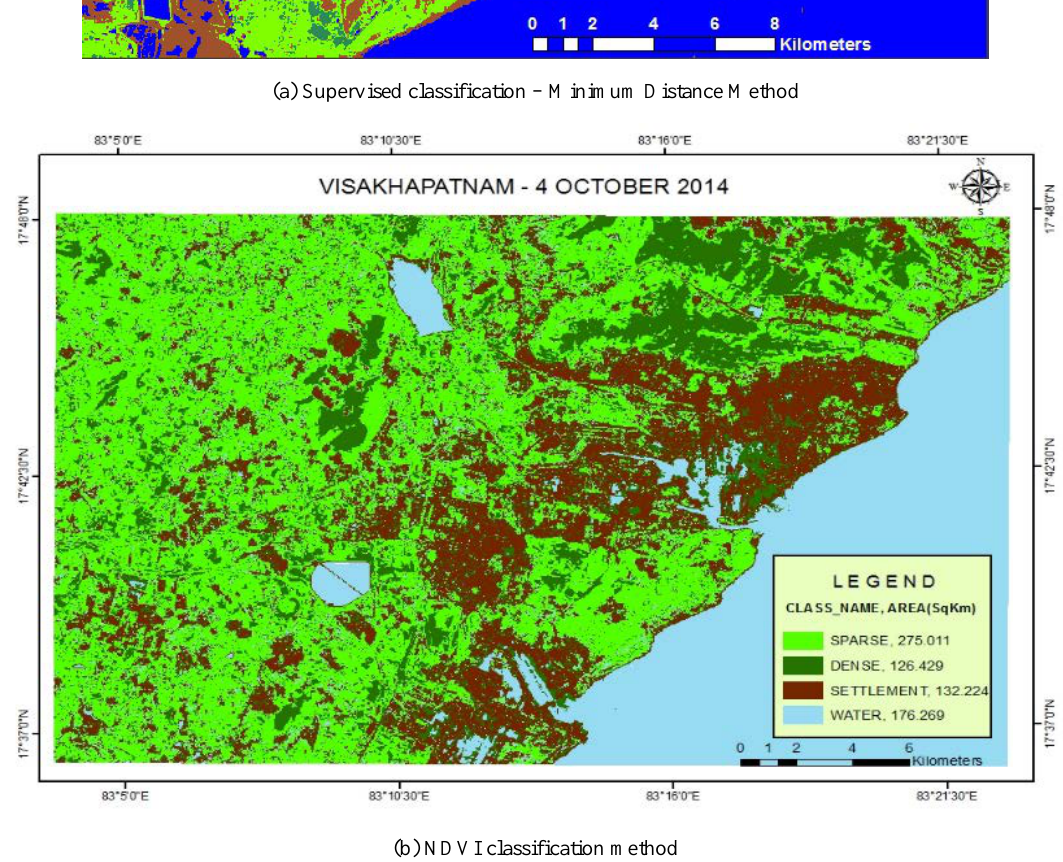
Figure 10. Comparison between supervised and NDVI classification